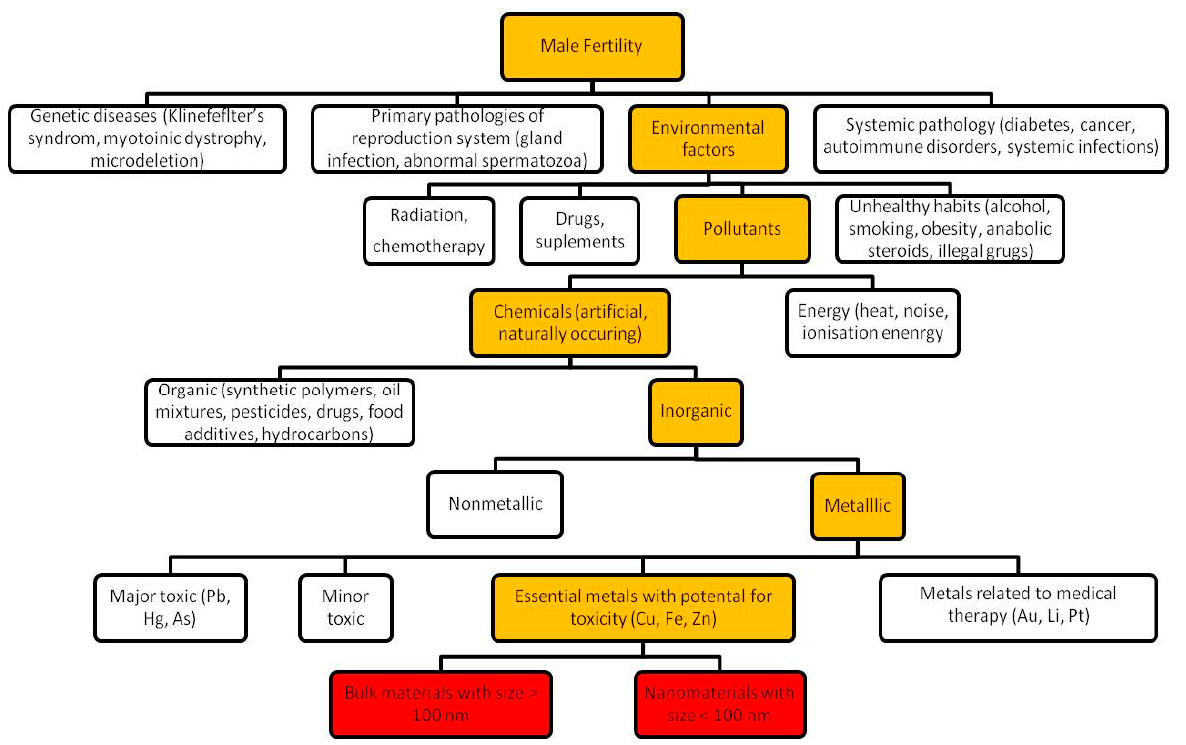
Figure 1. Causes of male infertility. This review is devoted to essential metals with potential toxicity and covers bulk materials and nanomaterials. Orange boxes show the connection of infertility with the subject of this review.